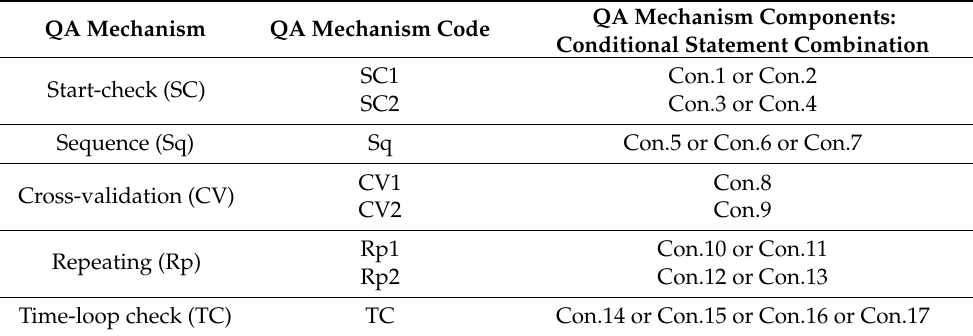
Table 2. QA mechanisms implemented in the citizen air-pollution-related symptoms questionnaire, with less (1) and more (2) robust variants.